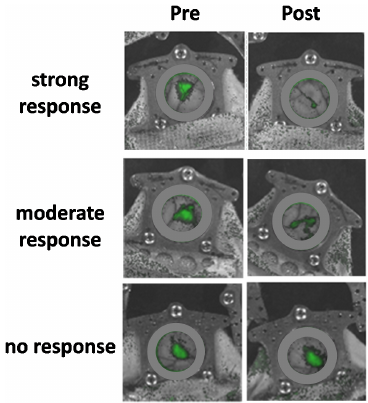
Fig. 2. Representative BLI for the di®erent levels of treatment response at 5 d post treatment. The green signal is the false- color intensity of the BLI signal. The ring in the gray-scale photograph in each case delineates the transparent window within which the bioluminescence (and °uorescence) images are